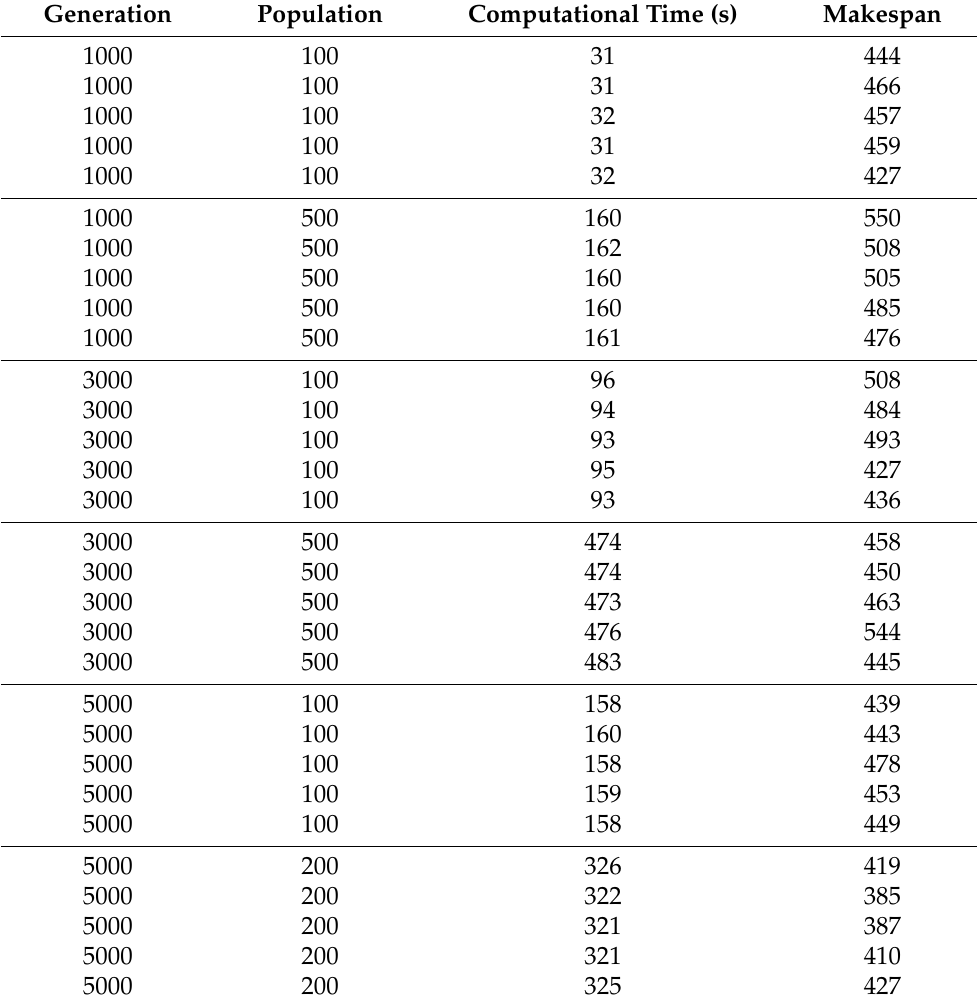
Table 1. Parameter tuning with fixed Mutation and crossover